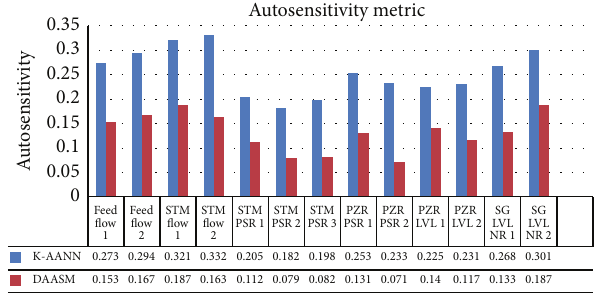
Figure 7: Layerwise invariance in DAASM. Lower curves depict higher invariance.